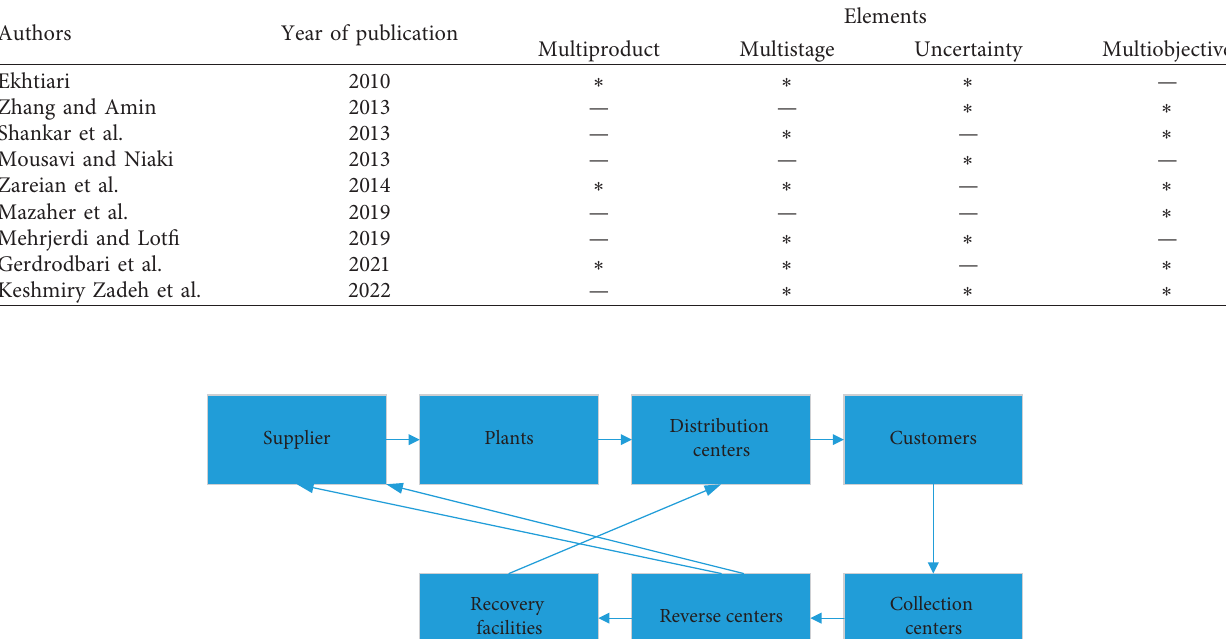
Table 1: Literature